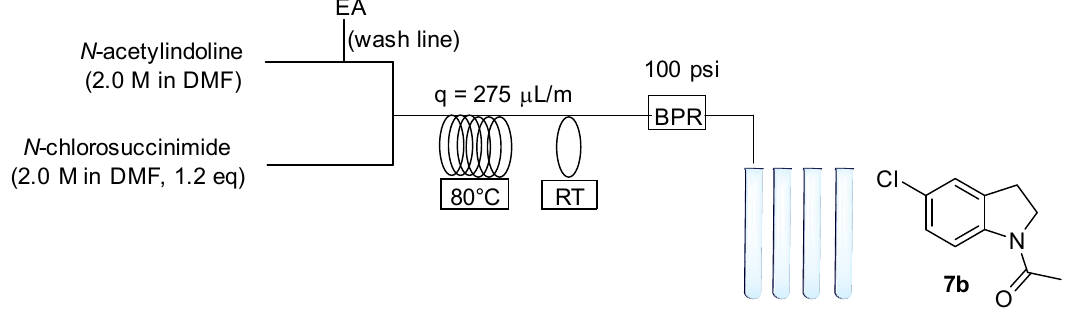
Figure 4. Flow chemistry apparatus for preparation of N -acetyl-5-chloroindoline 7b .